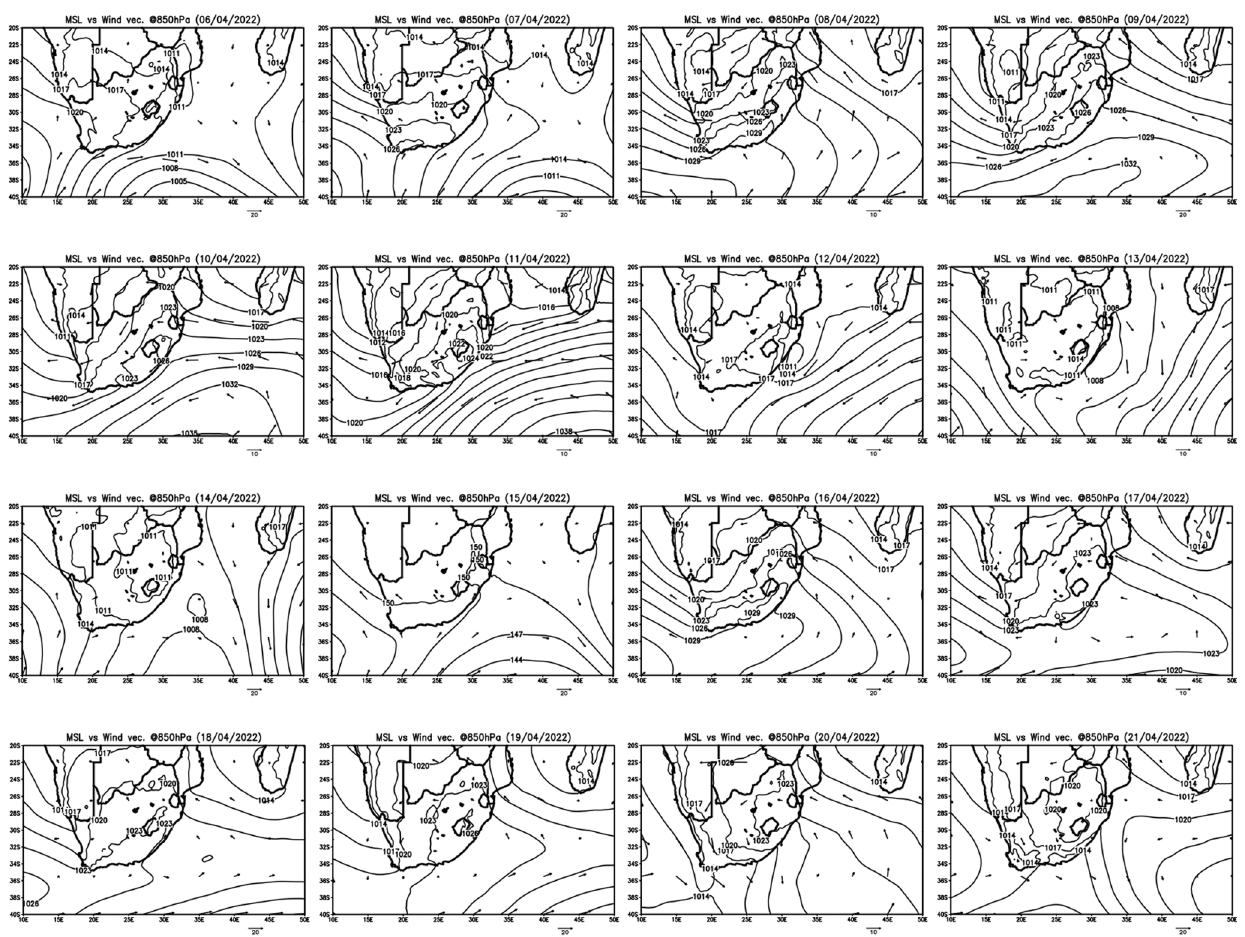
Figure 4. ERA5 mean sea level pressure and wind vectors at 850 hPa over South Africa during the period 6–21 April 2022.